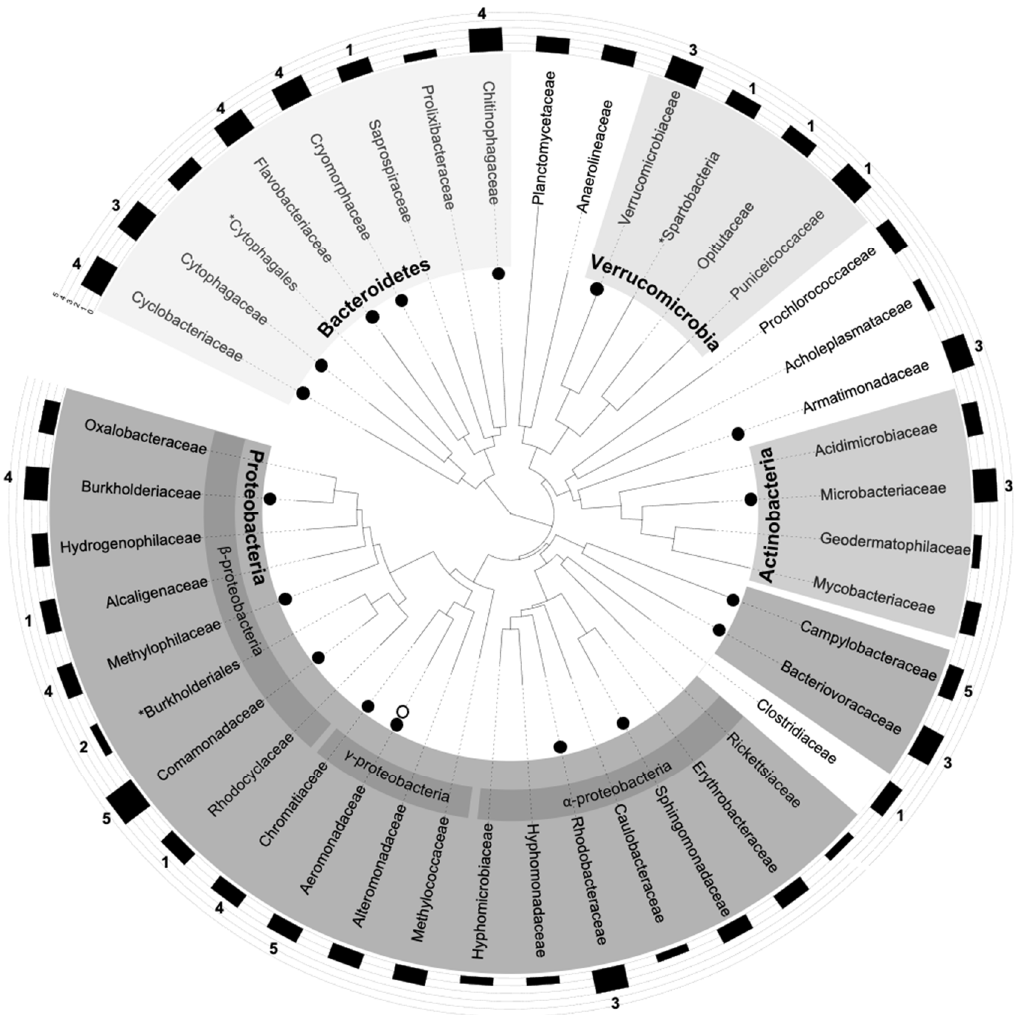
Figure 7. Host range of SXT/R391 ICEs in the Meurthe River water identified by epicPCR. The phylogenetic tree was constructed from family-level OTUs based on 16S rRNA gene amplicon sequences. The confidence levels of the presence of SXT/R391 elements in a bacteria family are indicated by numbers. Open and full black circles indicate taxonomic families where SXT/R391 elements have been previously detected or detected in the present work with a high level of confidence (LC ≥ 3), respectively. The black rectangles display the relative abundances of 16S rDNA reads for the considered family (Log10 (sum of OTU reads from a family/total reads of a sample) × 100,000). Asterisks are for unclassified families and undetermined OTUs are not shown.